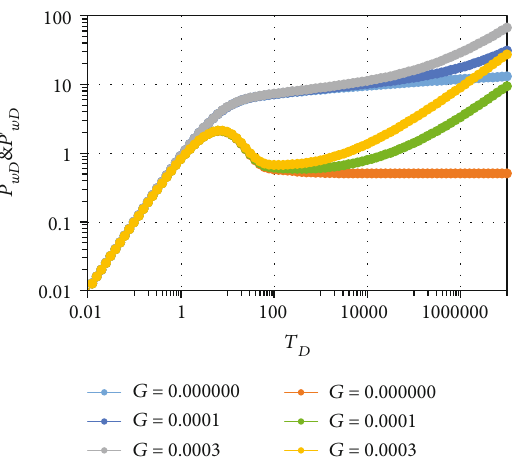
Figure 12: Typical curves under di ff erent threshold pressure gradients.